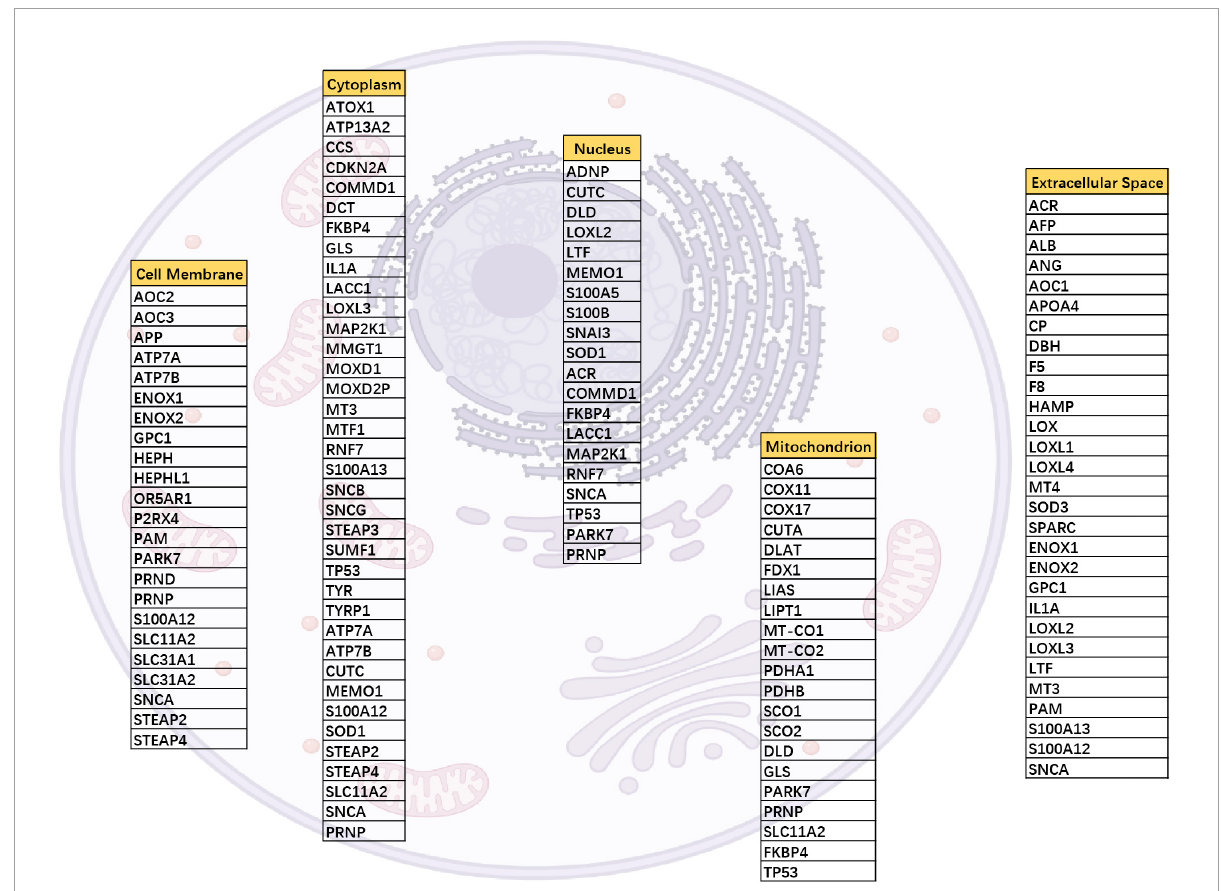
FIGURE1 Cellular localization of 90 copper-associated proteins. The distribution of copper-associated proteins was obtained from UniProt, and one protein may localize in various locations. For example, SNCA mapped to the cell membrane, cytoplasm, nucleus, and extracellular space.